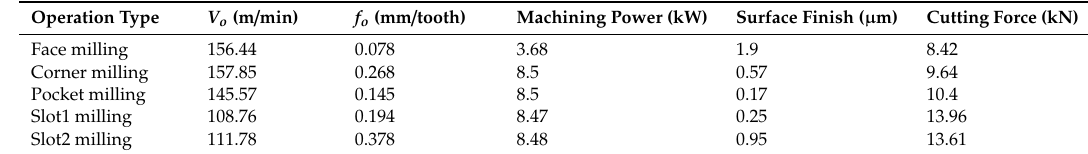
Table 12. Constraint values of optimum parameters.